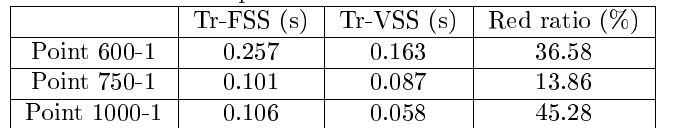
Table 2. Response time reduction.